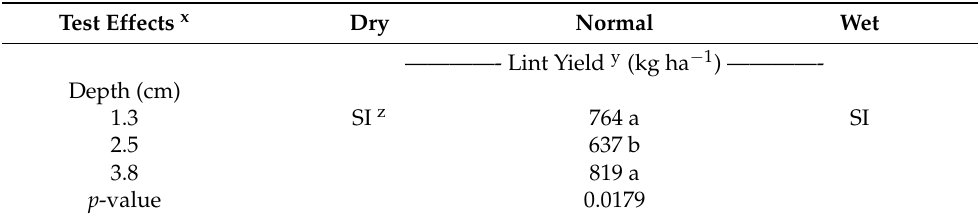
Table 11. Influence of seeding depth, cultivar, depth × downforce, and depth × cultivar on lint yield in different at-plant field conditions in